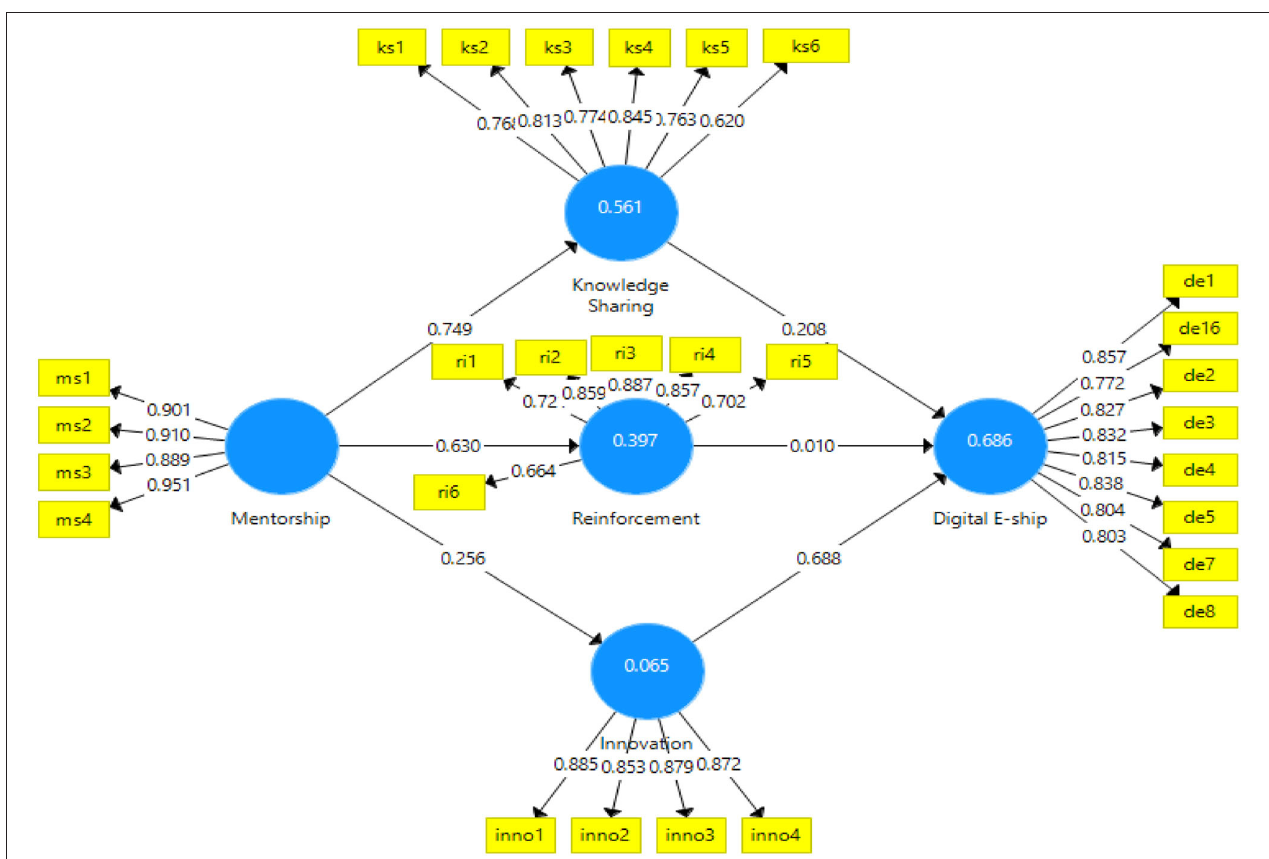
FIGURE 2 | PLS algorithm for measurement model. PLS, partial least